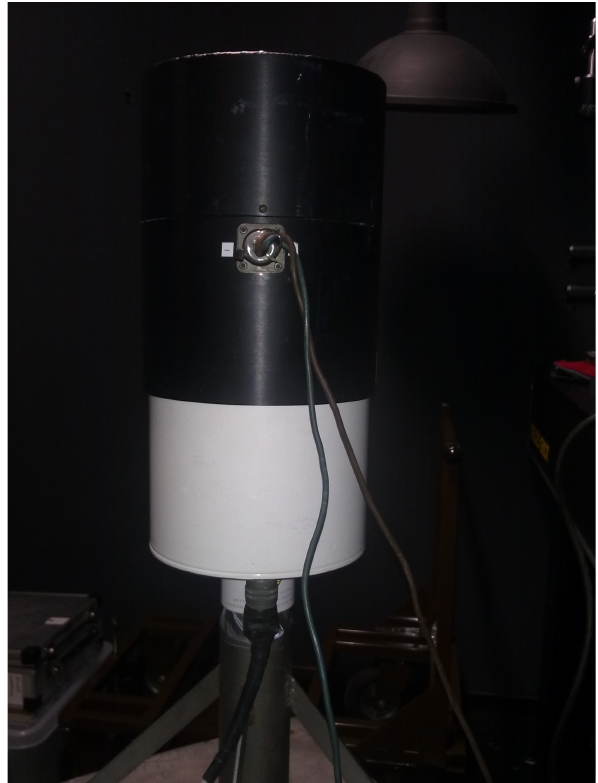
Figure 3. Lamp measurement of the NILU-UV radiometer. The NILU-UV is the white cylinder. The lamp is placed inside the black cylinder on the top of the